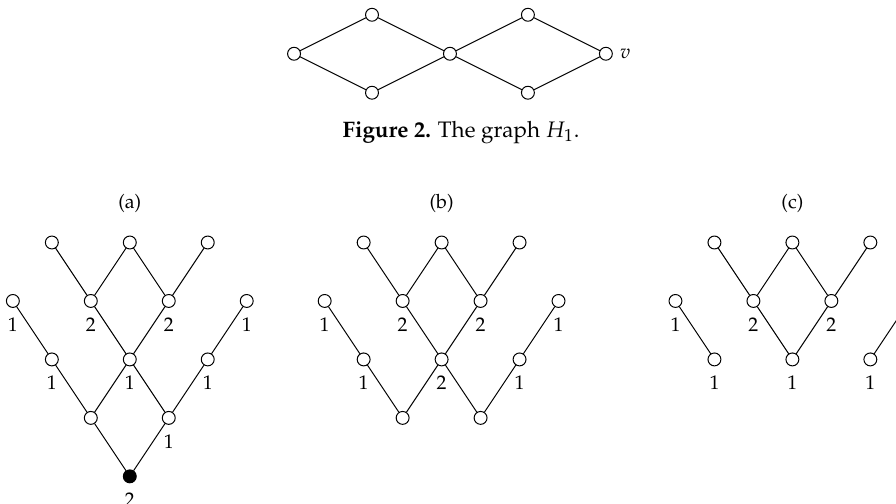
Figure 2. The graph H 1 .